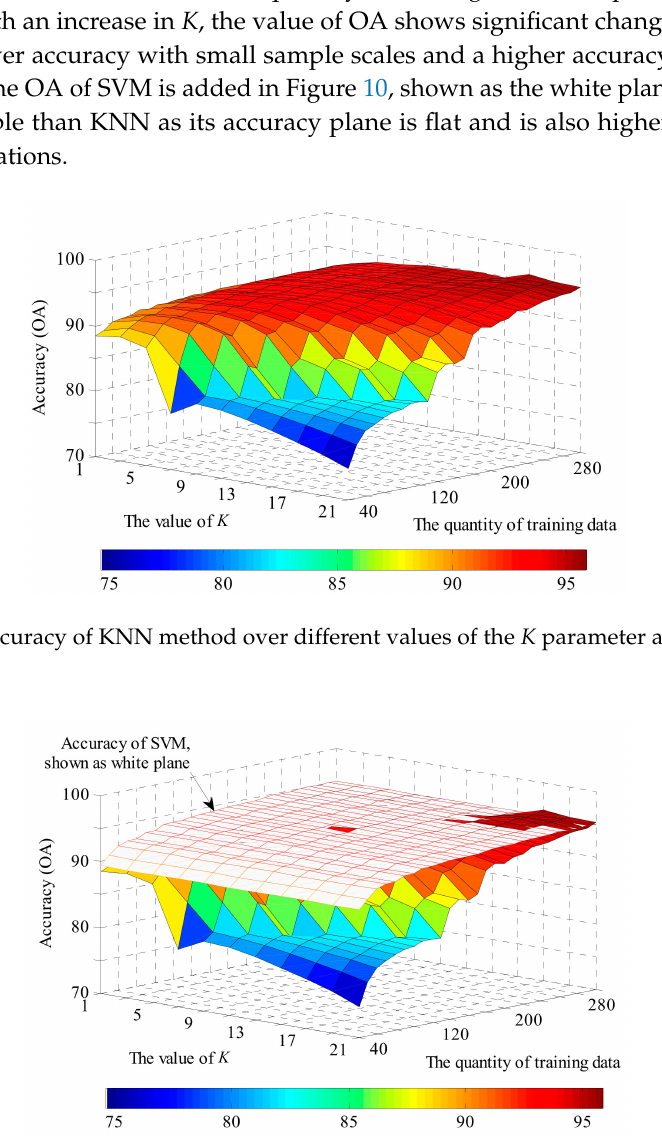
Figure 11. The accuracy of KNN compared with the support vector machines (SVM)